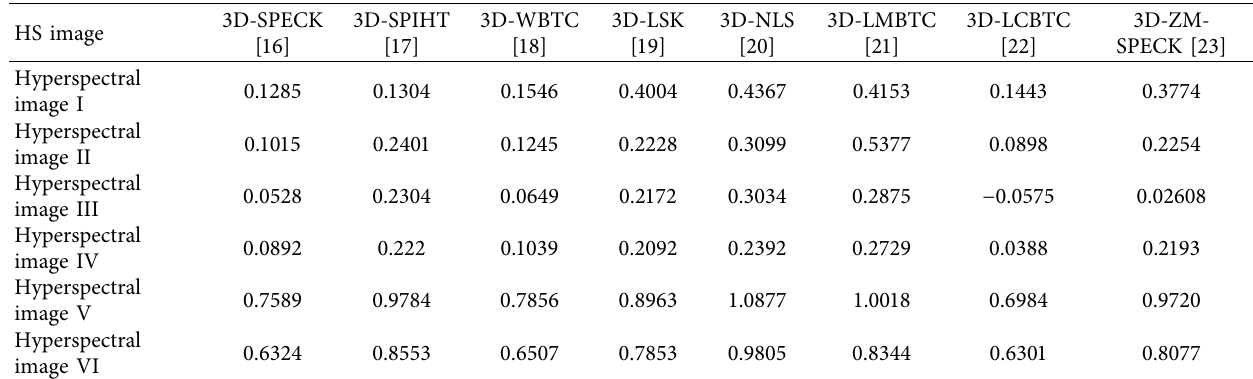
Table 5: Bjøntegaard delta PSNR gain of 3D-LEZSPC with other HS image compression algorithms for seven diferent bit